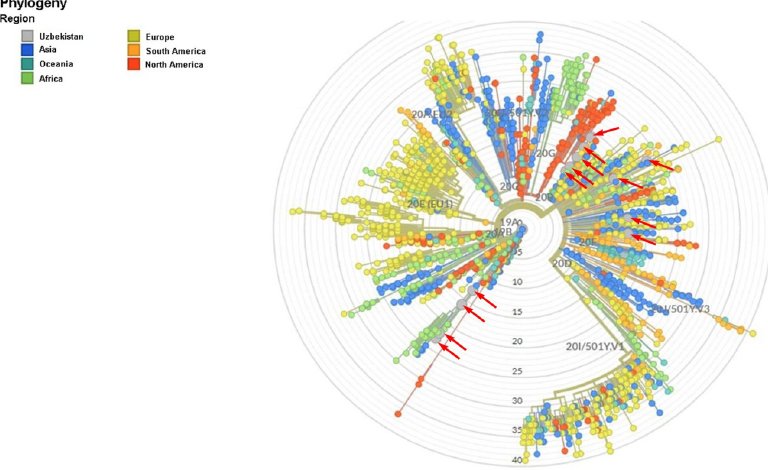
Fig 3. Global phylogenetic tree provided by nextstrain.org including COVID-19 samples from Uzbekistan. � Uzbekistan samples are shown with arrows, see S2 Table for variant and origin of Uzbekistan samples.